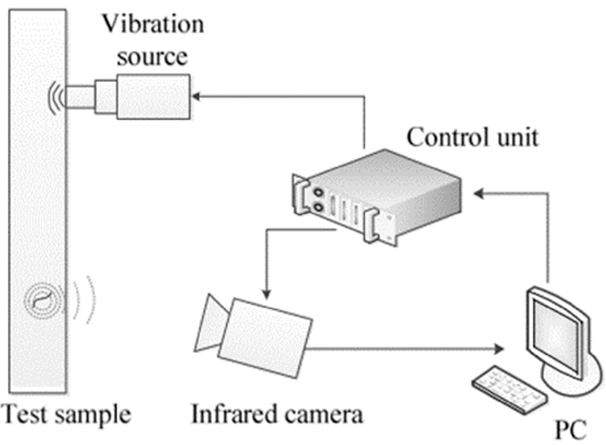
Figure 18. A picture of a vibrothermography setup [116].